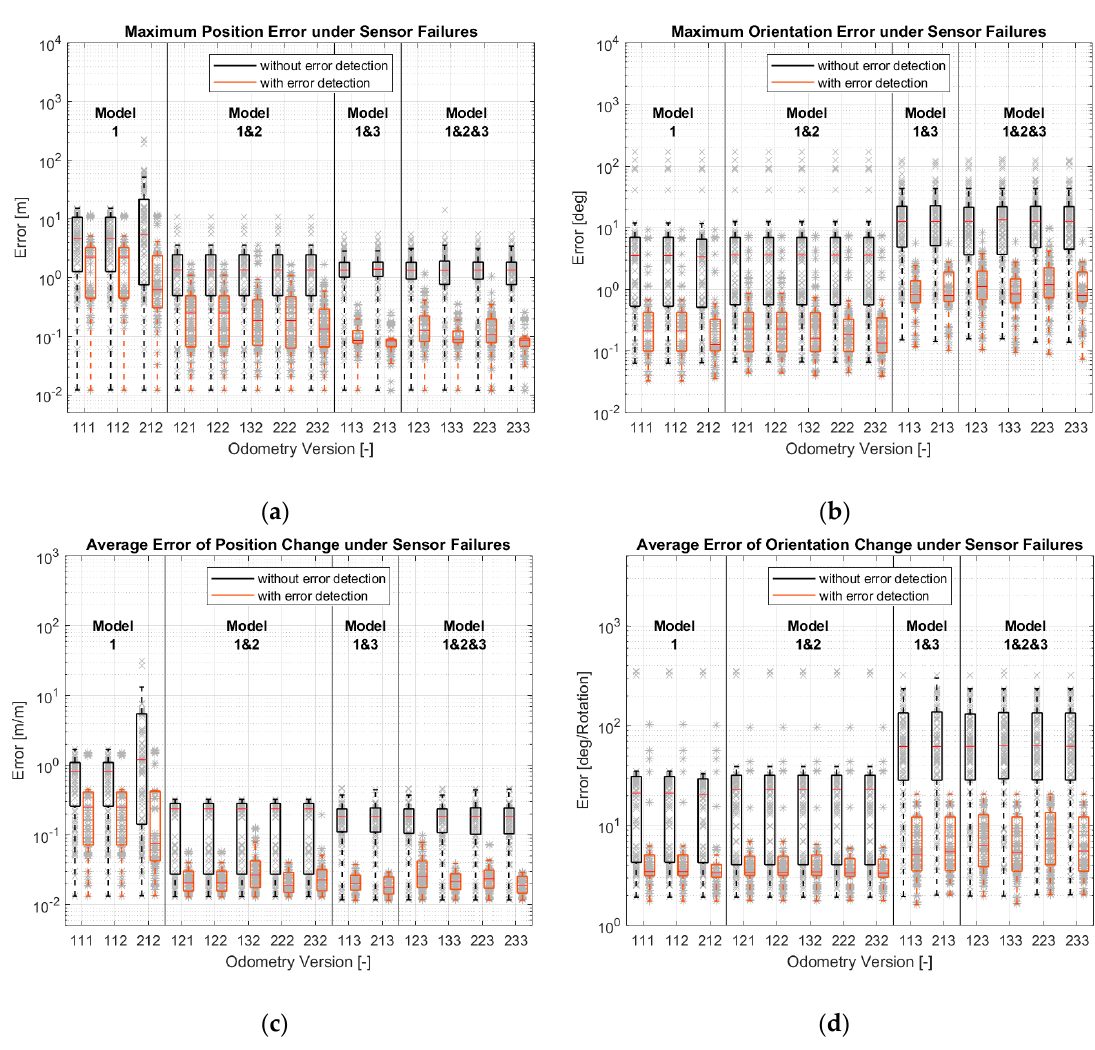
Figure 21. Simulation results of different odometry versions under sensor failures: ( a ) Maximum position errors; ( b ) Maximum orientation errors; ( c ) Maximum position errors; ( d ) Maximum orientation errors.